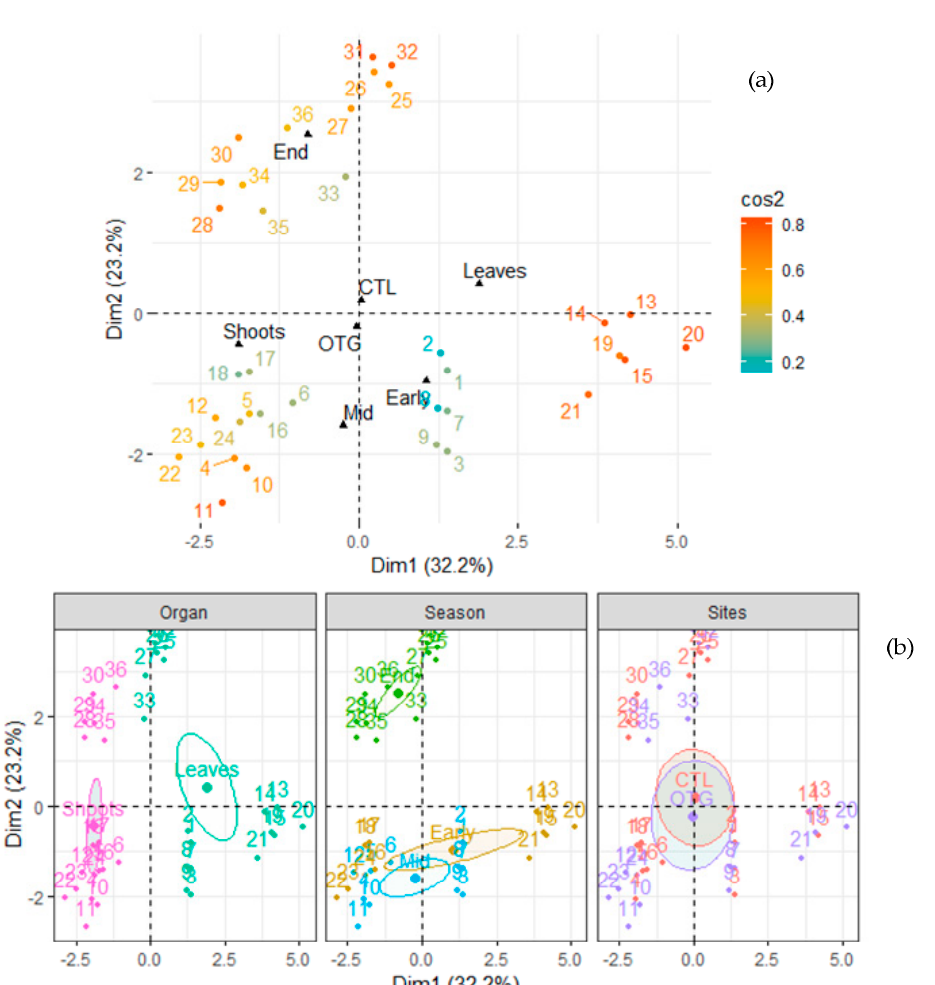
Figure 6. Factor analysis of mixed data (FAMD) used to show associations between quantitative variables (NSCs and nutrients) and qualitative variables (microsites, tissues and sampling seasons). On the factor map (a), 36 points represents characteristics of samples from 3 samples × 3 seasons × 2 organs × 2 sites. Cos2—the square of cosine value, represents the importance of the variable, a higher cos2 means this variable has a relatively larger contribution to the principal components, will distribute near the edge of the circle in the graph. Individual points with similar profiles are close to each other. On the factor map (b), multiple categorical variables were separately colored.